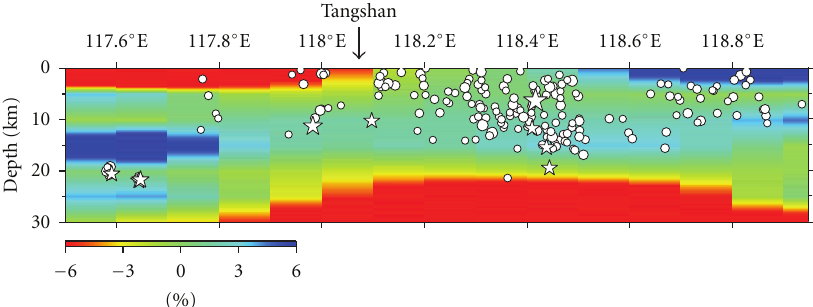
Figure 15: Vertical cross-section of P wave tomographic image along profile TT (cid:5) in Tangshan area. White stars and circles denote the earthquakes of M L ≥ 4.0 and M L < 4.0, respectively, the occurred within 0.25 ◦ o ff the profile. Red and blue colors denote slow and fast velocity anomalies, respectively. No vertical exaggeration. The location of profile TT (cid:5) is shown in Figure